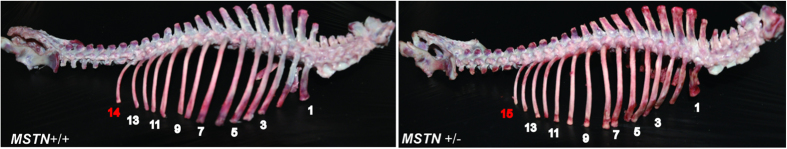
Skeletal patterns in wild-type and MSTN mutant Meishan (Ms) pigs.An example of one MSTN mutant pig (right) that contains fifteen thoracic vertebrae and one WT pig (left) that commonly contains fourteen thoracic vertebrae.